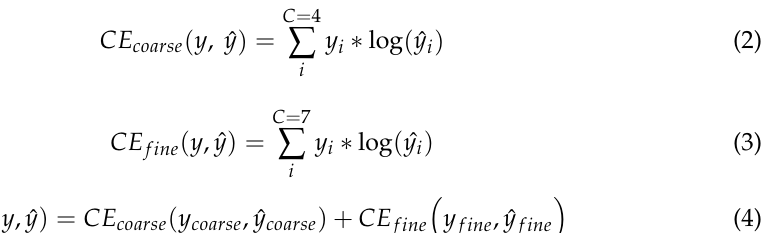
Figure 2. Illustration of data fusion technique on six combinations of blanket conditions. During the model training, the model parameters were determined by stochastic gradient descent to optimize the loss function. The outputs were passed to the categor- ical cross-entropy loss functions for both the coarse and fine classification, as shown in Equations (2) and (3). Finally, the total loss function was constructed based on a simple sum of losses, as shown in Equation (4):